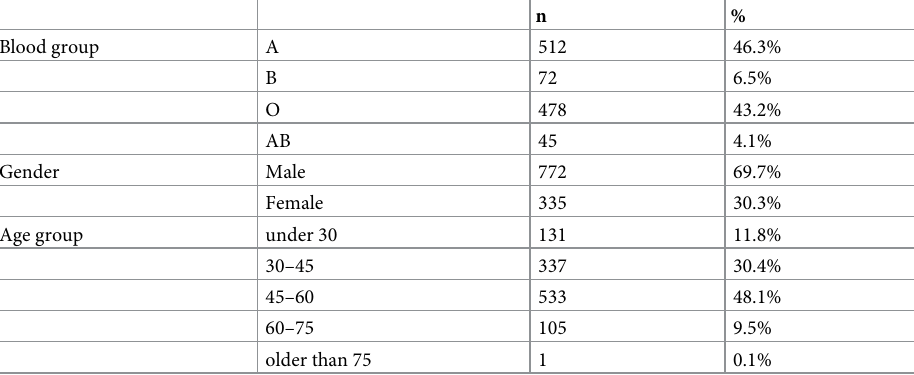
Table 1. Baseline characteristics of repeat donors.